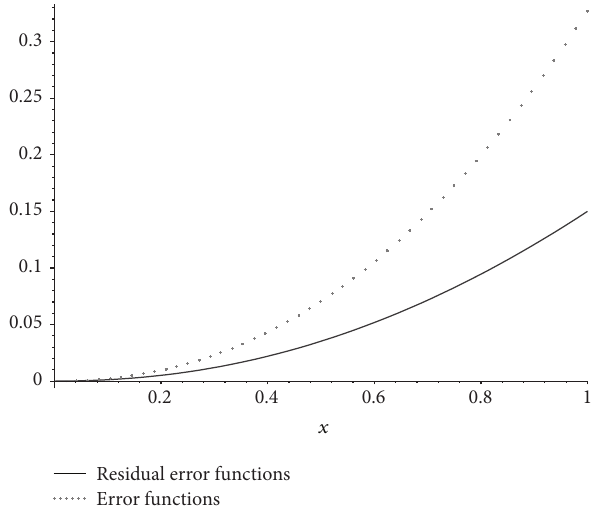
Figure 5: Comparison of error and residual error functions for 𝑦 8,10 values.